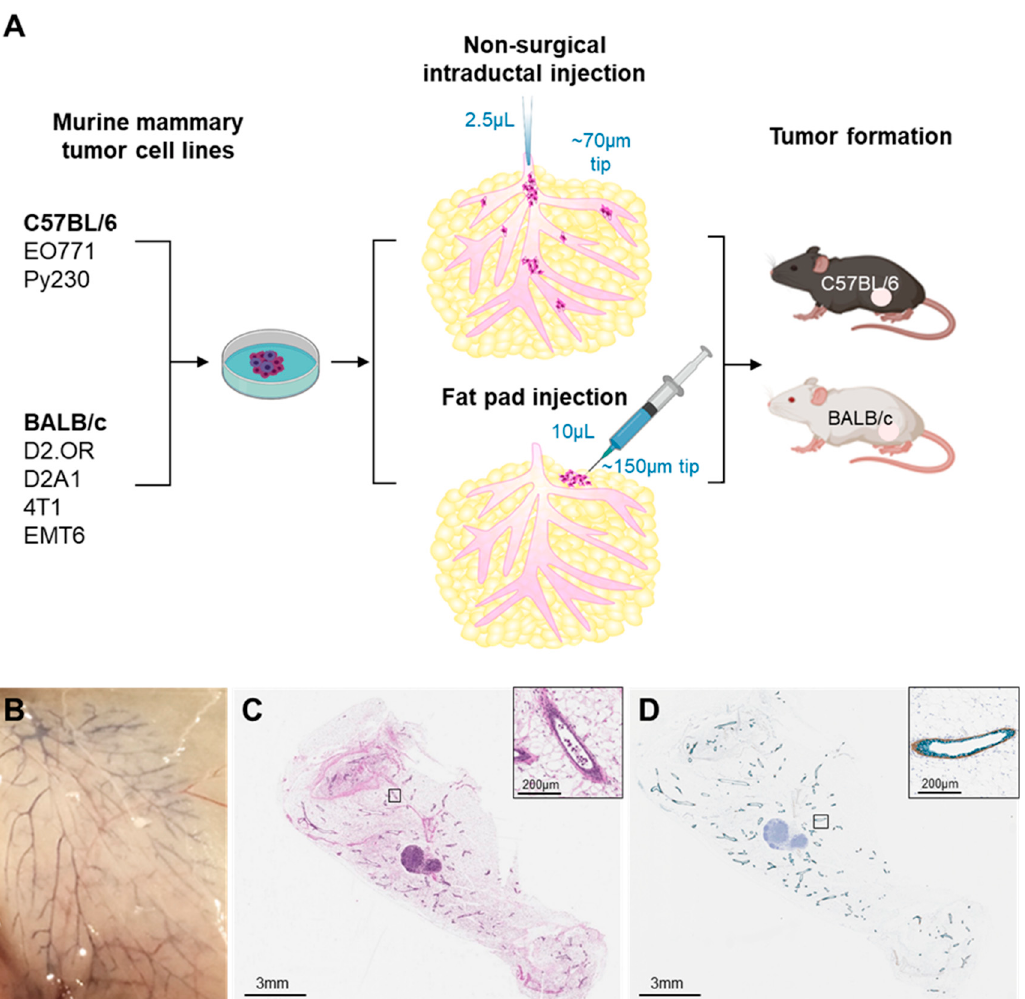
Figure 1. Validation of tumor cell dispersion and maintenance of ductal integrity after intraductal tumor cell delivery. ( A ) Schematic overview of the experimental procedure. ( B ) Dispersion of trypan blue dye (0.4% in PBS, 5 µL) throughout the mammary ductal tree following intraductal injection into the mammary gland of C57BL/6 mice. ( C ) Hematoxylin–eosin staining of mammary glands collected immediately after intraductal injection of EO771 cells (1 × 10 5 cells in 5 µL). ( D ) Immunohistochemical analysis of E-cadherin (green) and calponin (brown) expression demonstrating maintained ductal and myoepithelial cell layer integrity. Insets show higher magni fi cation.